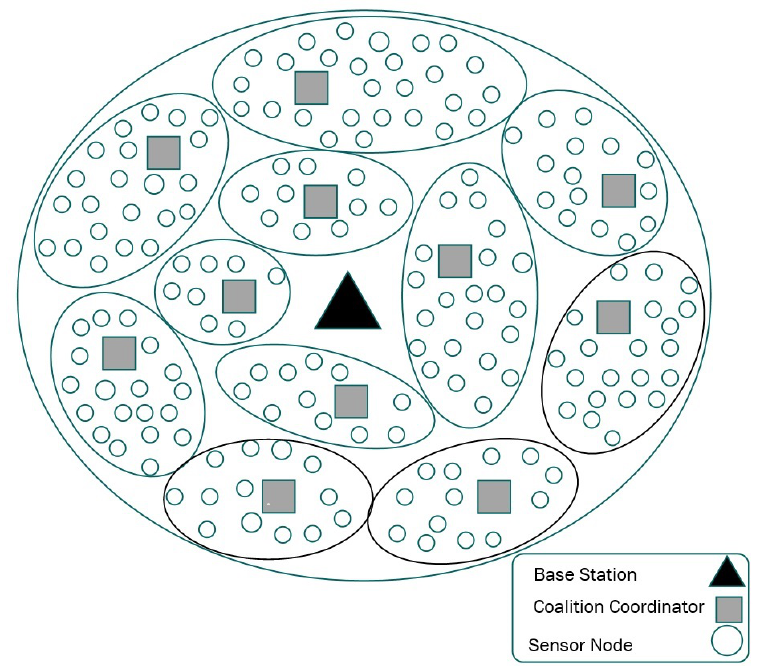
Figure 5. Coalition